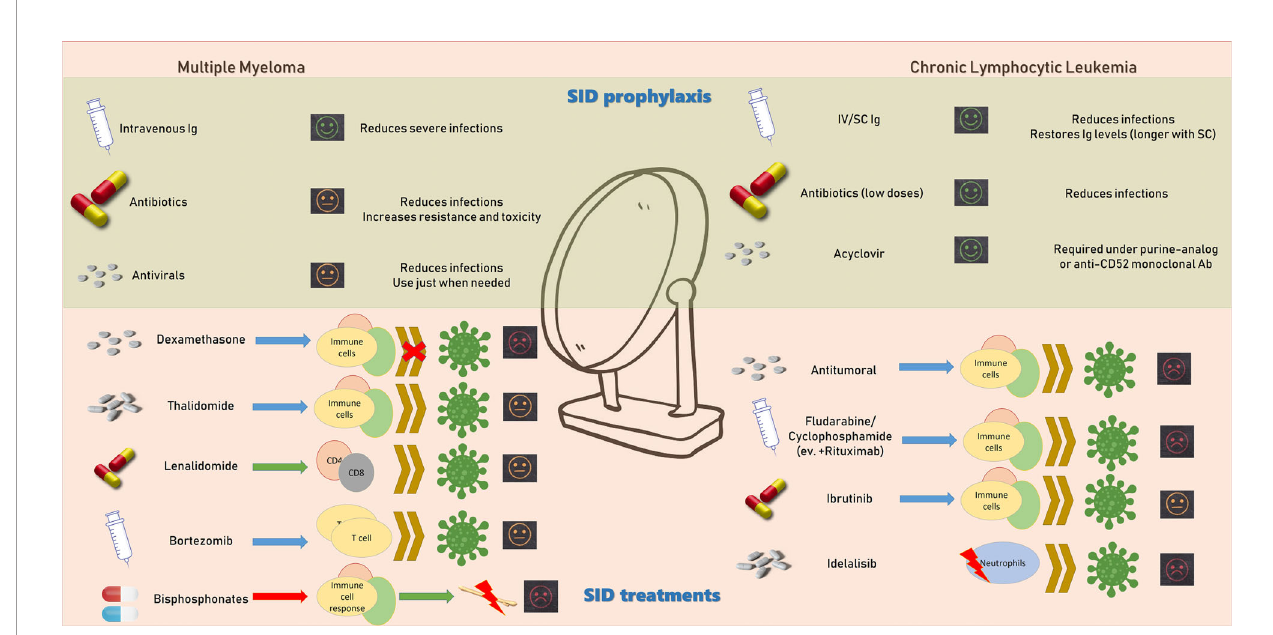
FIGURE 3 | Possible immunological targets of drugs used in the prophylaxis and treatment of secondary immunode fi ciency of patients with multiple myeloma and chronic lymphocytic leukemia. Action of antineoplastic drugs on immunological